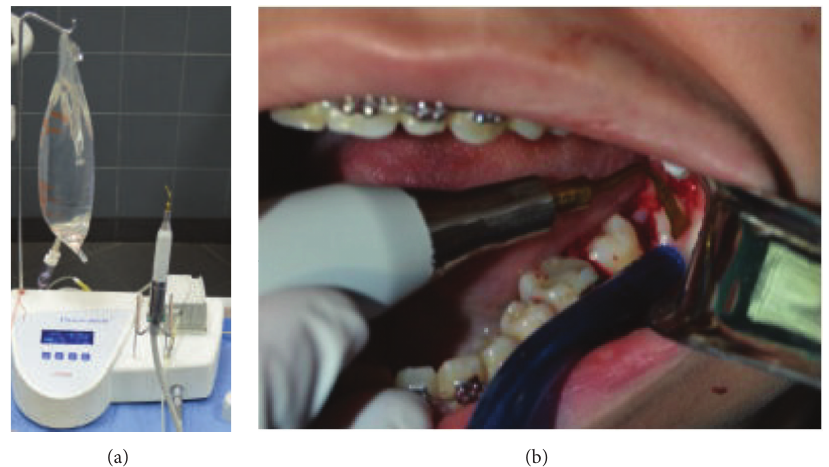
Figure 1: (a) Piezosurgery device and (b) bone guttering around impacted mandibular third molar using piezosurgery (test site).